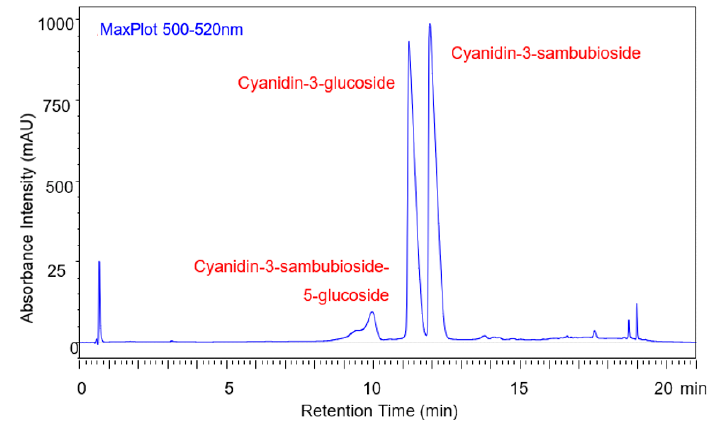
Figure 1. Elderberry anthocyanins before incubation with caffeic acid. uHPLC-PDA-MS/MS settings were as follows: 0.25 mL/min flow, 50 °C oven temperature, 50 μ L injection volume, and the following acetonitrile gradient: 0% at 0 min, 26% at 19 min, 30% at 20 to 21 min, 0% at 21 min.